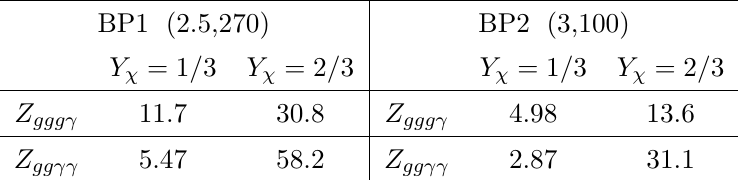
BP1 (2.5,270) BP2 (3,100)